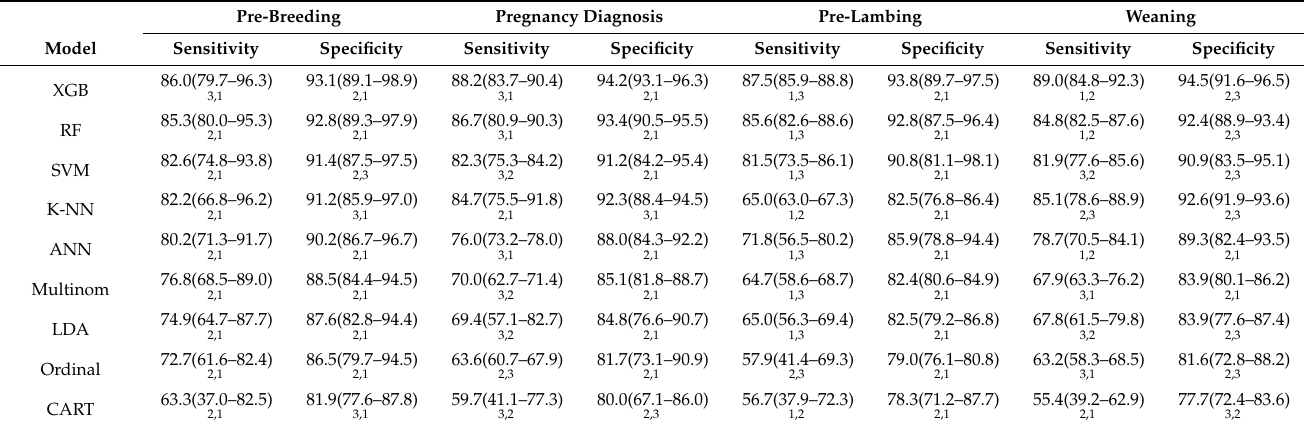
Table 3. Indicators of authenticity (sensitivity and specificity) of nine predictive models for ewe BCS at 43–54 months of age at different stages of the annual cycle. Values in parenthesis denote the minimum and maximum sensitivity or specificity, in ascending